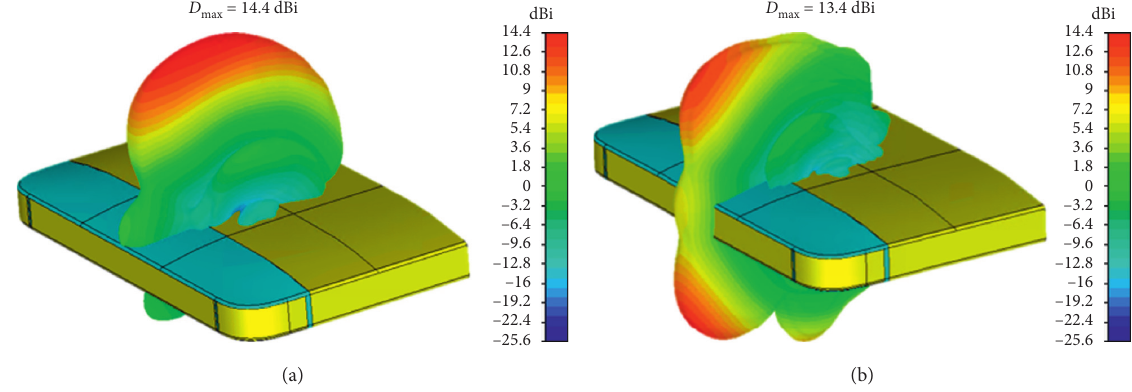
Figure 5: Antenna array radiation patterns for ψ � 90 ° with form factor integration: (a) PBS; (b)